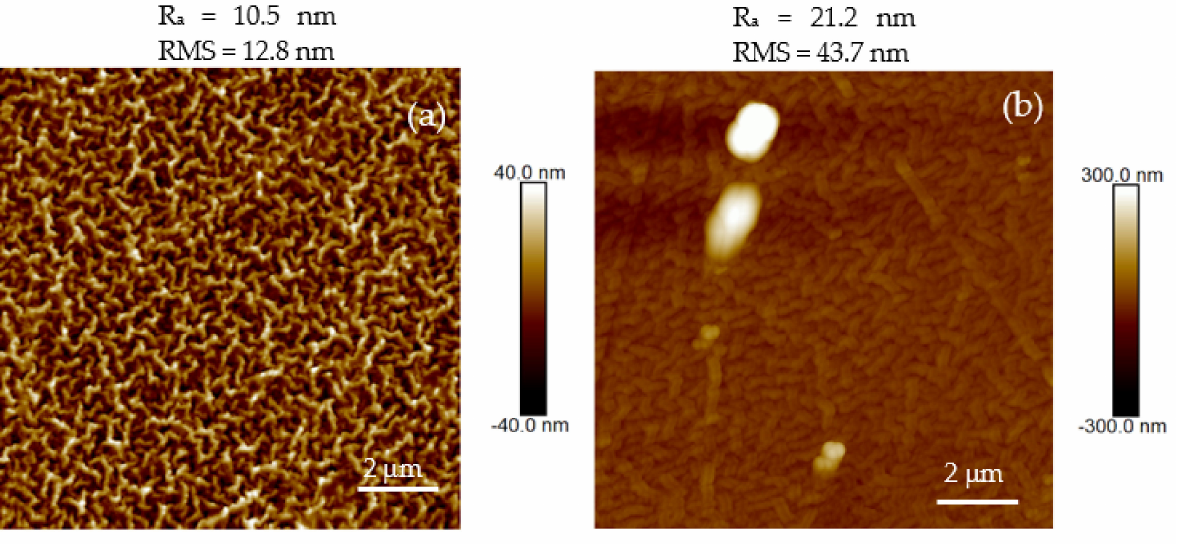
Figure 5. AFM images of the pristine COC ( a ) and of the deposited COC ( b ).